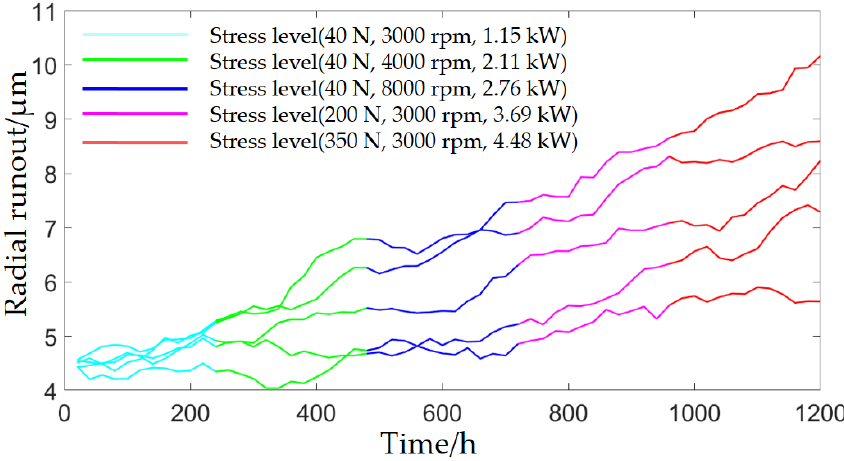
Figure 1. The performance degradation track of motorized spindle.